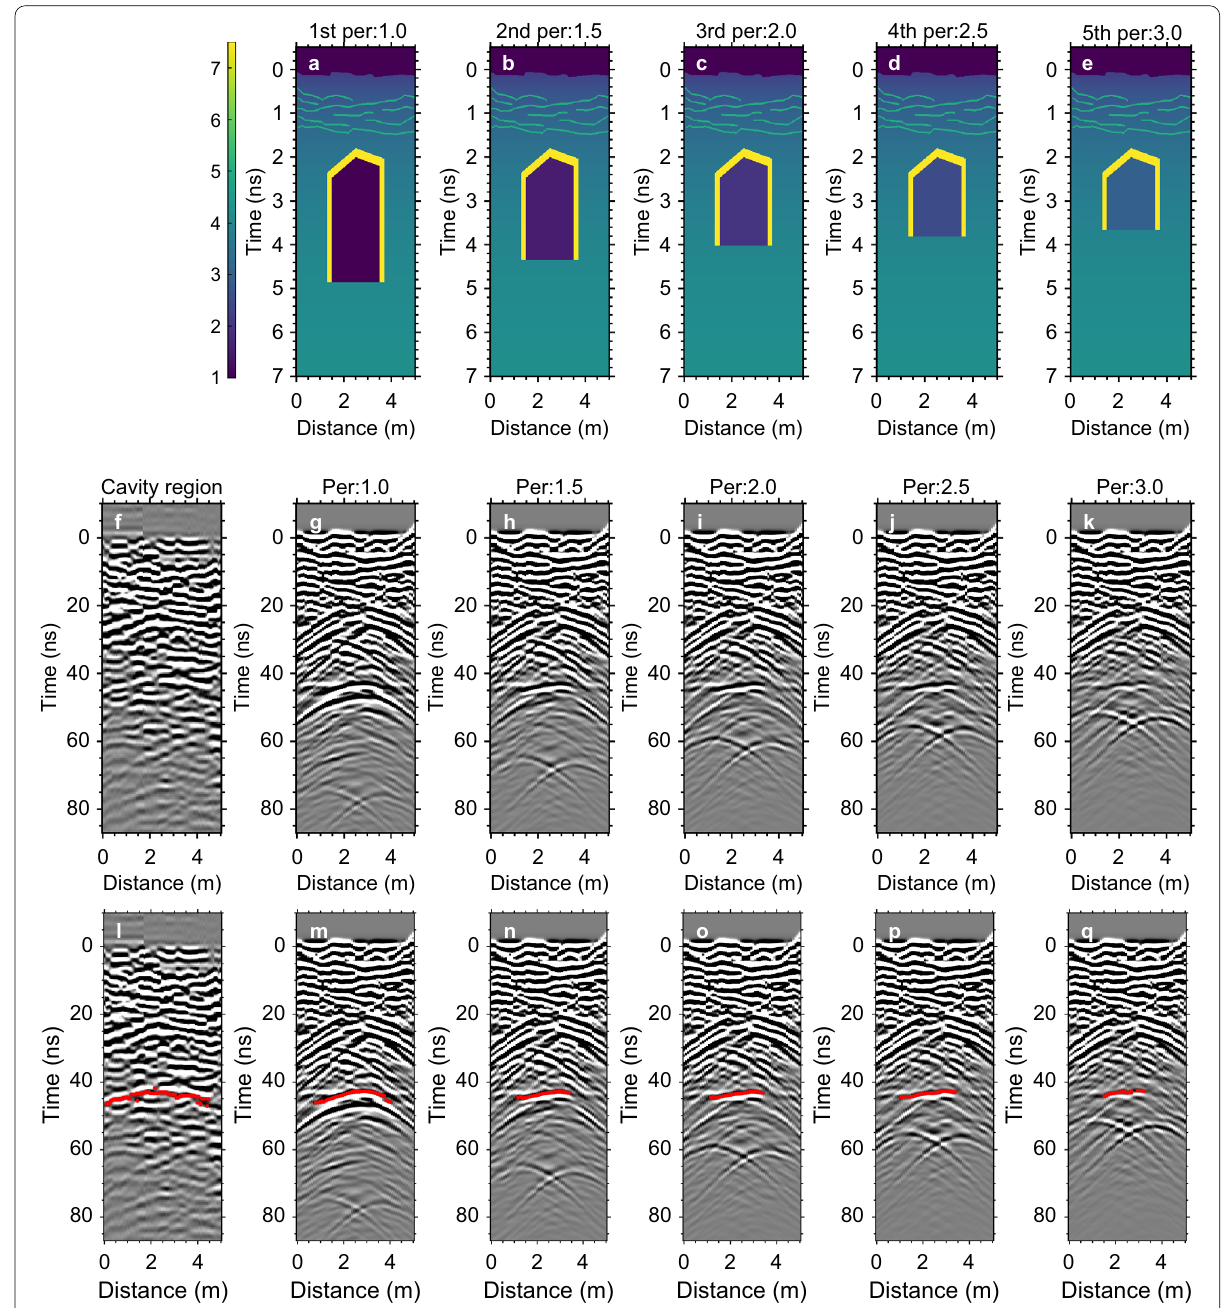
Fig. 4 Comparison between the observed bottom radargram and those simulated for subsurface low-permittivity zones that have different dielectric constants. The regolith models use the depth profile of the dielectric constant that is adapted from the Apollo core samples, and